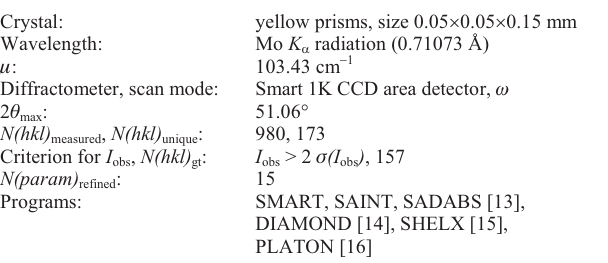
Table 1. Data collection and